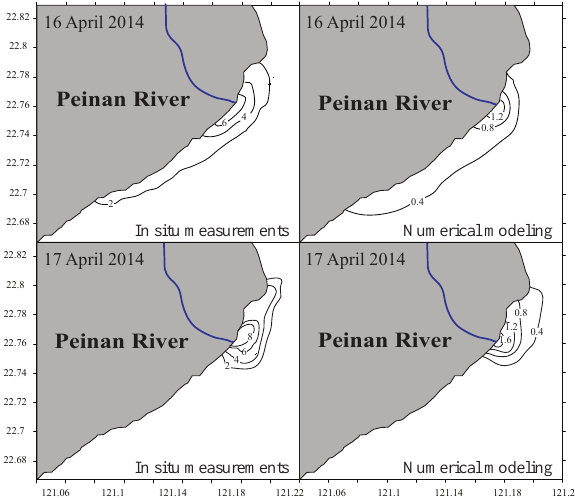
Figure 5. Surface distribution of turbidity obtained from the in situ measurements (left panels; 2, 4, 6, and 8 NTU isolines) and sus- pended sediment concentration simulated by the numerical model (right panels; 0.4, 0.8, 1.2, and 1.6gL − 1 isolines) on 16 April 2014 (top panels) and 17 April 2014 (bottom